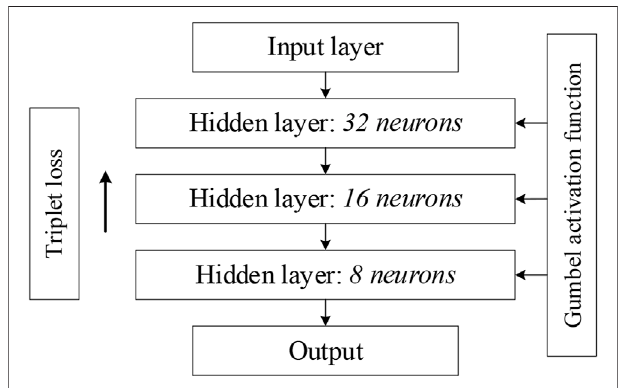
FIGURE 2 | Deep neural network framework for feature extraction.